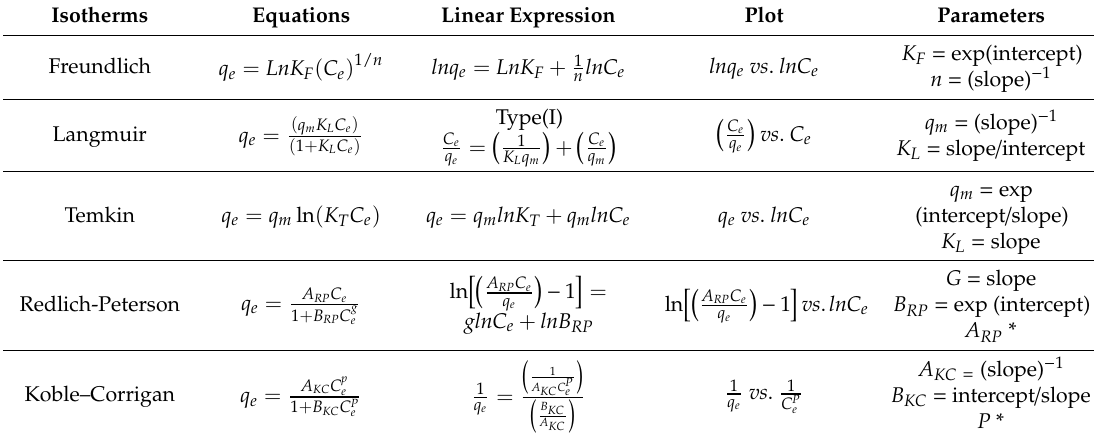
Table 2. Isotherms and their linearized expressions.